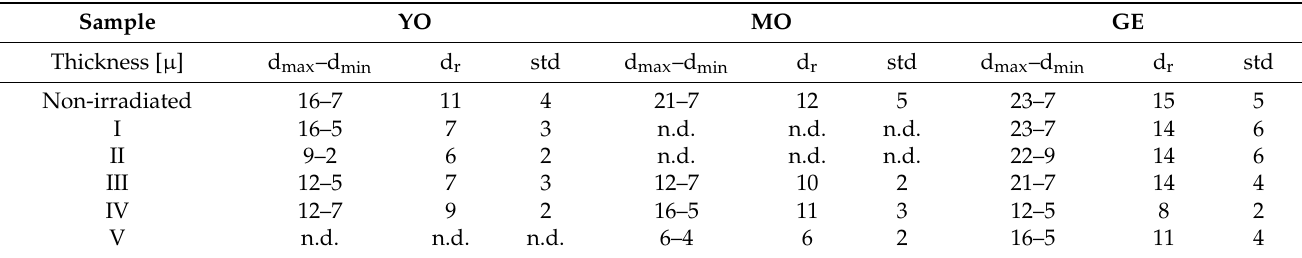
Table 6. Maximum, minimum and mean thickness values (respectively d max , d min , d r ) of the shellac layer before and after I–V laser treatments. Standard deviation is a measure of the thickness variability. N.d. stands for not detectable thickness (i.e., below the instrumental limit of detection which is about 3.5 µ m in z